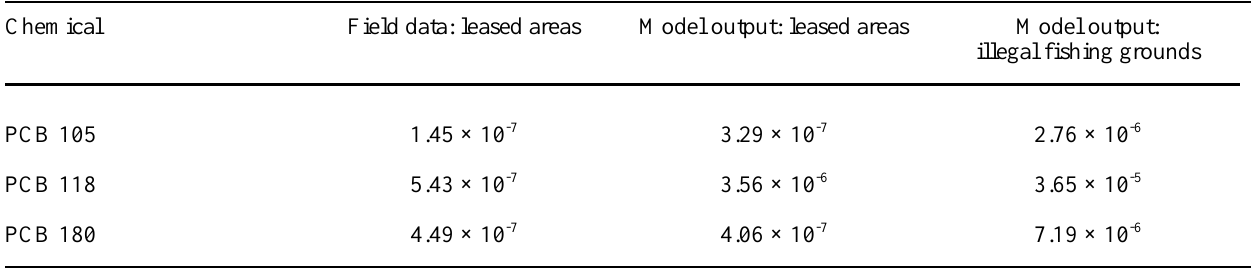
Table 3. Contamination levels in clam tissue and samples. The model is not very sensitive to the small differences in pollutants among leased areas, but it recognizes that PCB concentrations in the top sediment around industrial areas are at least an order of magnitude higher than in the rest of the